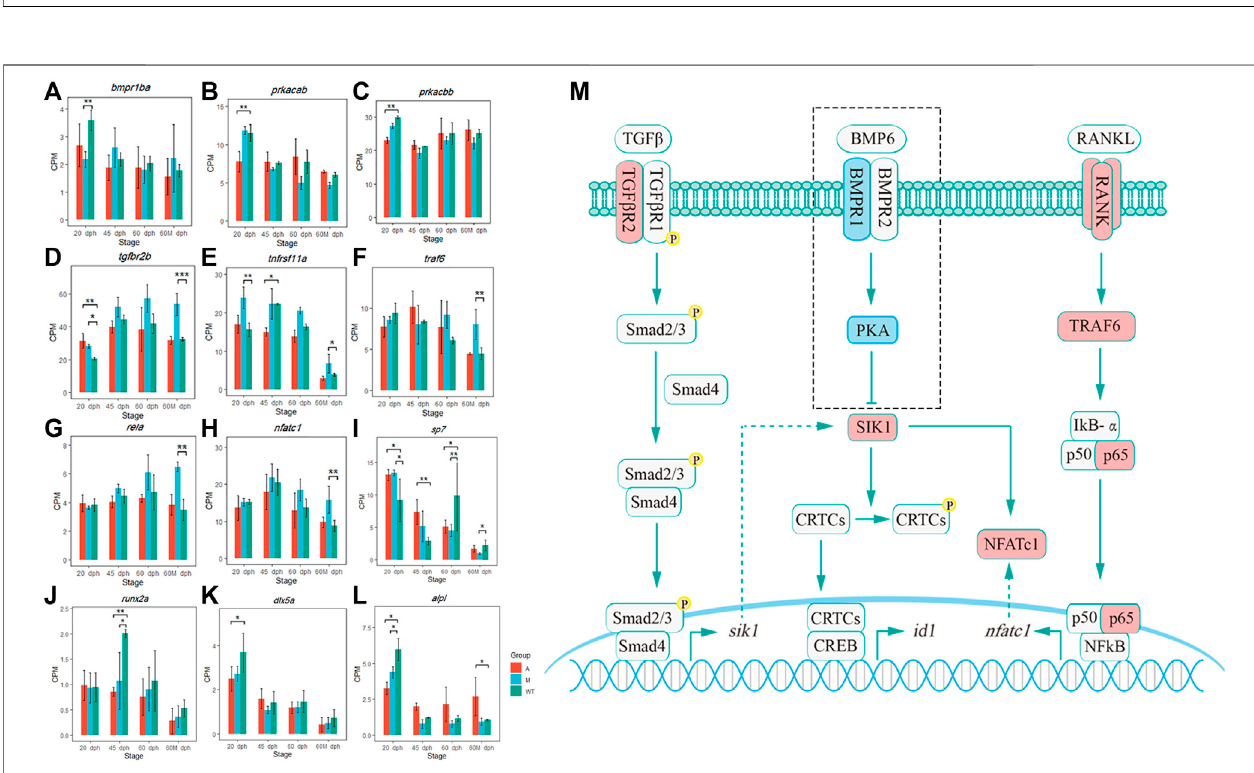
FIGURE9| Pathwayhypothesis thatbmp6regulates IBdevelopment. (A – L) Expressionlevelof bmpr1ba , prkacab , prkacbb , tgfbr2b , tnfrsf11a , traf6 , rela , nfatc1 , sp7 , runx2a , dlx5a , and alpl in different groups. * p < 0.05, ** p < 0.01, and *** p < 0.001 (M) Pathway hypothesis that bmp6 regulates IB development. The red box represented that its mRNA was upregulated and the blue box represented that its mRNA was downregulated in the mutants compared to that in the wild-type.